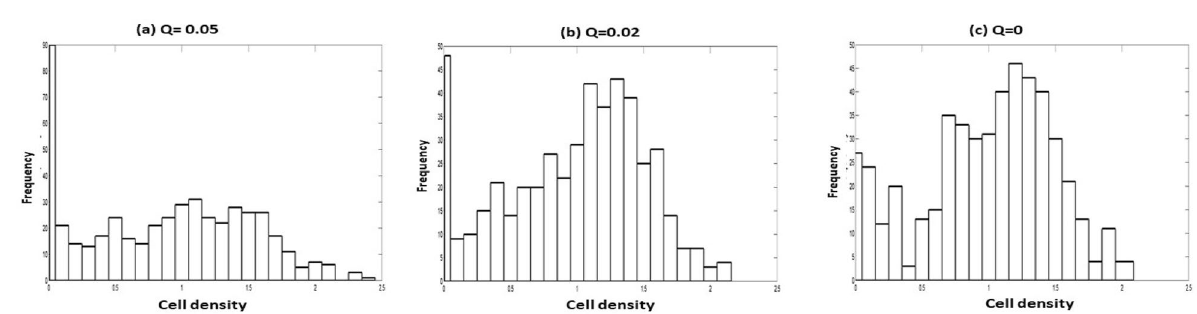
Figure 11. Distribution of cell density for r p (cid:31) 0.01 , and variable strength of multiplicative noise: ( a ) D 0.5 , Q = =